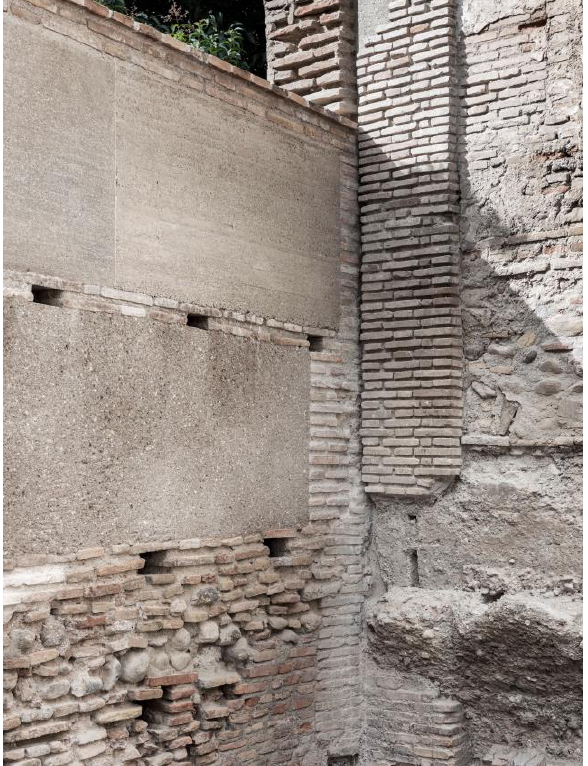
Figure 8. Final state of the rammed earth wall after the consolidation works. Photograph: Cristina García-Zarza.